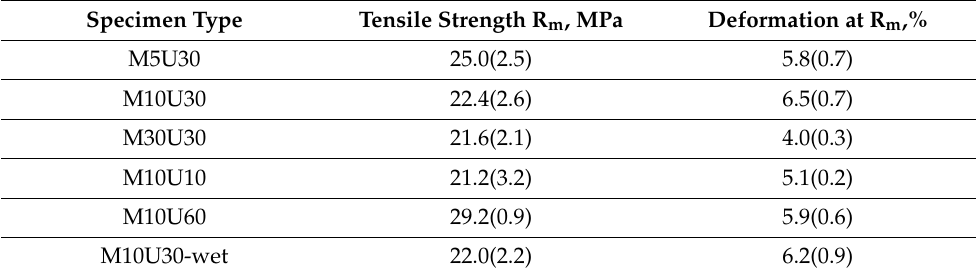
Table 2. The results of static tensile tests of the produced printouts.